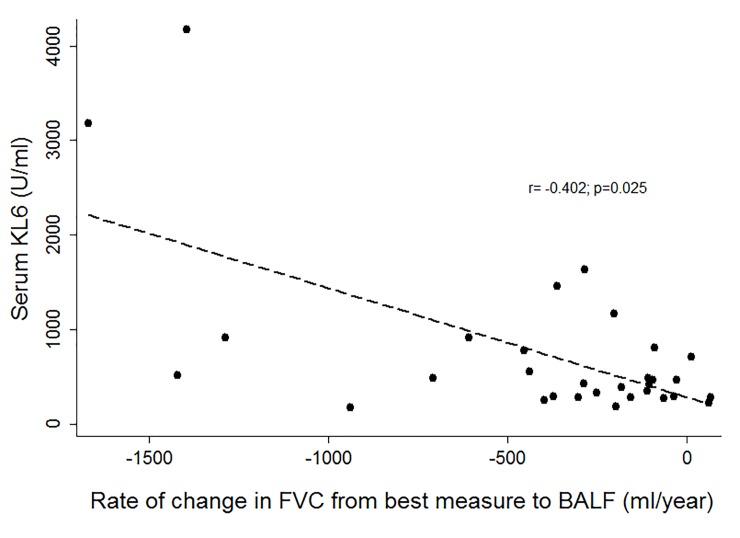
Correlation between the rate of change per year in forced vital capacity (FVC) from baseline to enrollment and serum KL-6 levels in CLAD patients.